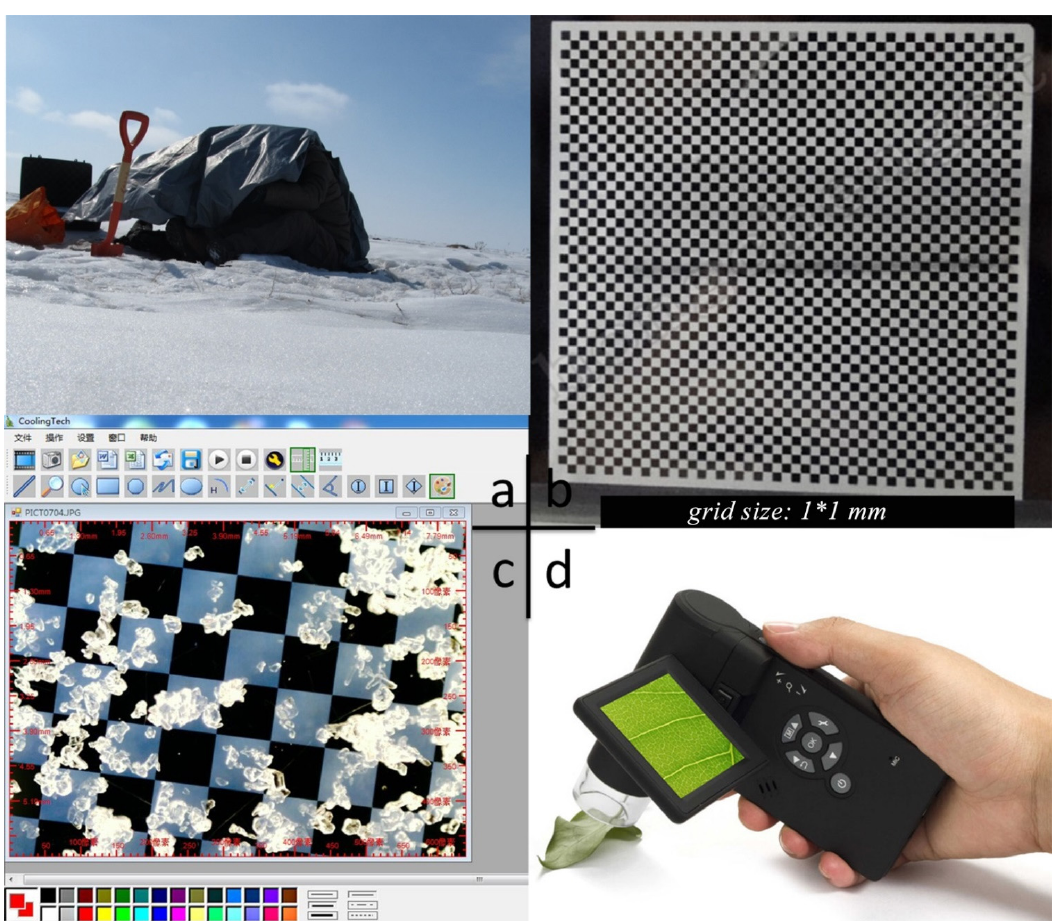
Figure 2. Procedures for measuring snow grain sizes ( a ) in the field, ( b ) using a 1 mm × 1 mm check- erboard, ( c ) Cooling Tech software, and ( d ) a portable high-definition digital microscope.